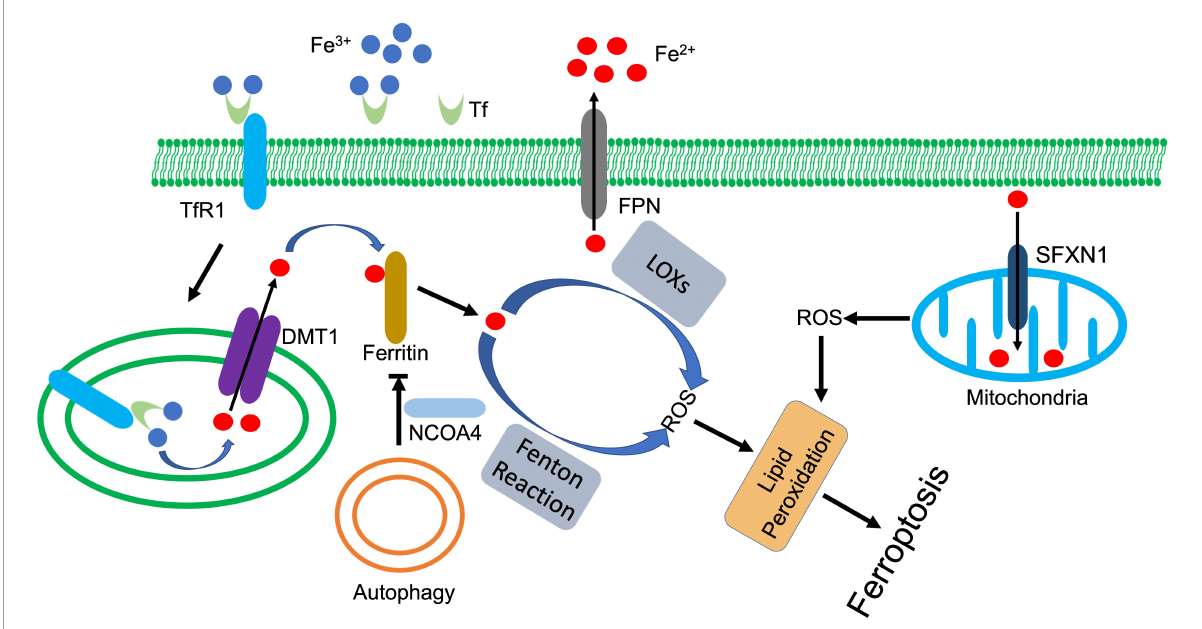
FIGURE3 Iron metabolism and ferroptosis. Ferric state of iron (Fe 3 + ) is bound to transferrin (Tf) in serum. Transferrin receptor 1 (TfR1) recognizes and binds the complex, which facilitates the endocytosis of ferric iron. The six-transmembrane epithelial antigen of the prostate-3 (Steap3) and acidic environment of the endosome jointly promote the reduction and release of ferrous iron (Fe 2 + ). Divalent metal transporter 1 (DMT1) transports ferrous iron to cytoplasm, which is tightly controlled by ferritin. Autophagy (or ferritinophagy) selectively degrades ferritin with the coordination of nuclear receptor coactivator 4 (NCOA4), whose downregulation releases ferrous iron to activate lipid peroxidation, ultimately leading to ferroptosis. In addition, ferrous iron also triggers mitochondria-derived ROS through siderofexin (SFXN1). Ferroportin1 (FPN) can transport ferrous iron out of cell, which decreases the intracellular concentration of ferrous